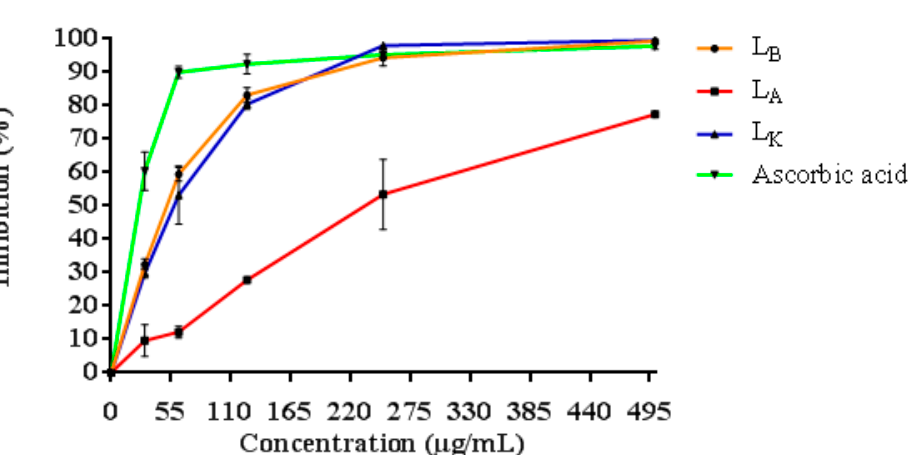
Figure 1. Scavenging activity of LSEO A , LSEO B , LSEO K , and ascorbic acid.